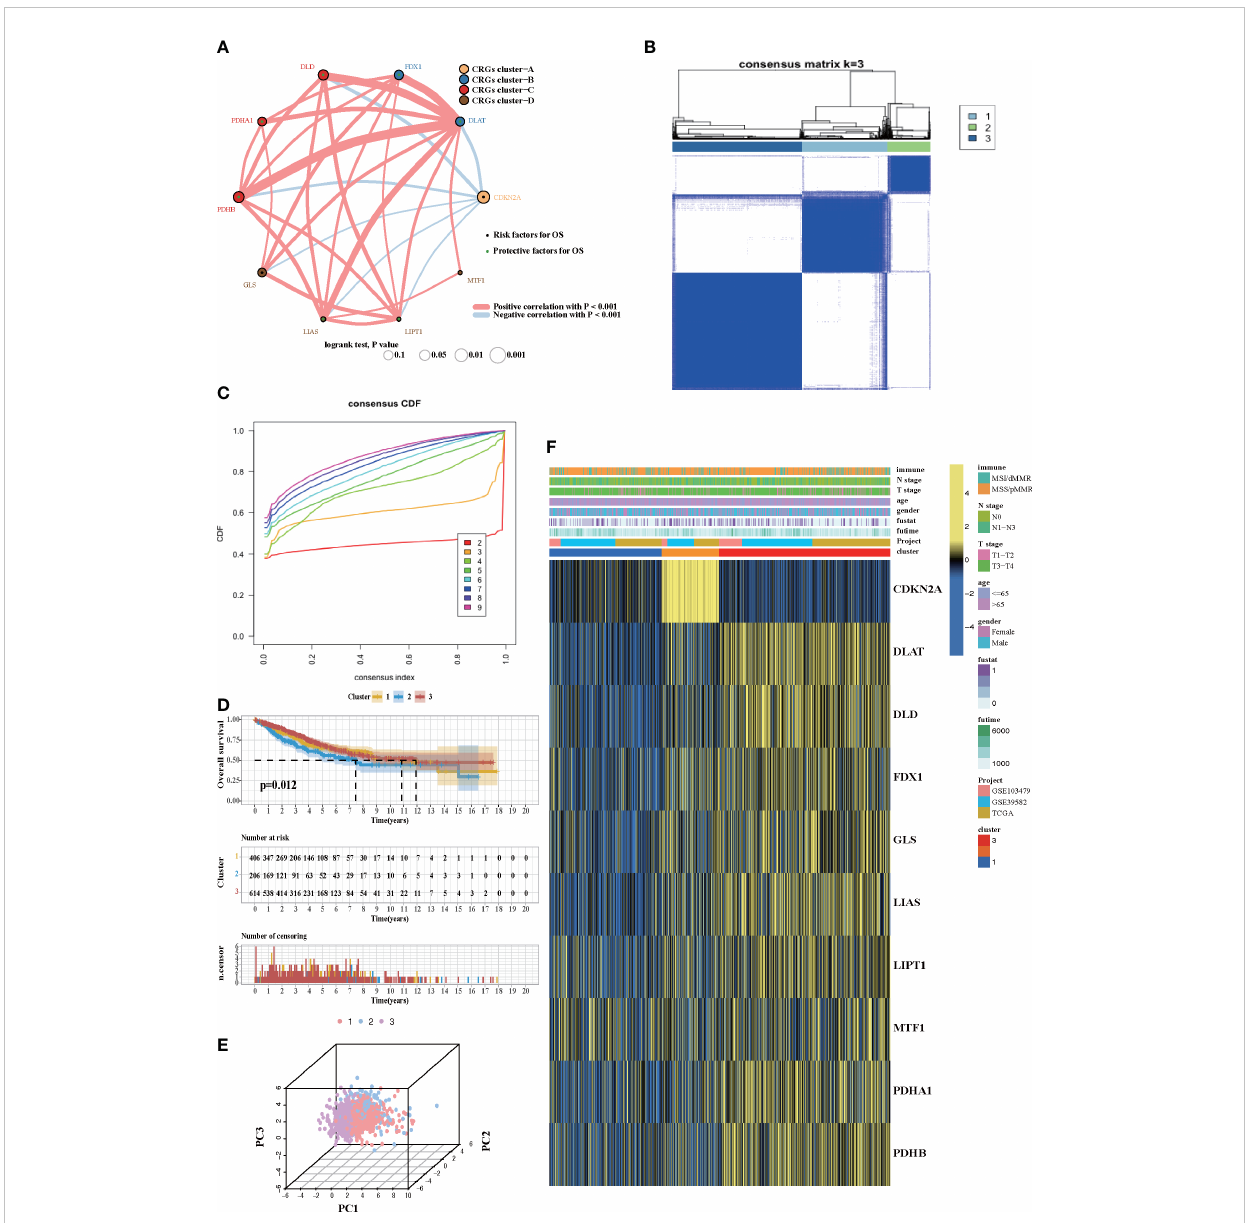
FIGURE 2 Cuprotosis patterns in CRC patients. (A) The network between 10 CRGs in CRC patients. The size of the circle corresponded to the effect of each gene on the patients ’ prognosis, and the range of values was scaled by log-rank test. Protective factor for patients ’ OS was illustrated by a green dot, and risk factors was illustrated by a black dot. The lines showed the interaction of each gene, and the thickness represented the correlation strength. Blue lines indicated negative correlation, and red lines indicated positive correlation. The CRG cluster A – D was marked with yellow, blue, red, and brown, respectively. (B) Unsupervised consensus clustering for 10 CRGs in the meta-cohort and the consensus matrices for k = 3. (C) Consensus values range from 0 to 1. (D) Kaplan – Meier curves for the three cuprotosis patterns based on 1,226 CRC patients from the meta-cohort, including 406 samples in COPcluster C1, 206 samples in COPcluster C2, and 614 samples in COPcluster C3 (log-rank test). The COPcluster C3 showed a signi fi cantly better prognosis than the other two COPclusters. (E) The transcriptome pro fi les of three cuprotosis patterns were analyzed by principal component analysis, revealing a striking difference in transcriptome pro fi les between different patterns. (F) Expression heatmap of three COPclusters of 10 CRGs in the meta-cohort. Immune subtype, age, gender, N stage, T stage, and prognosis were annotated. Yellow represents a high expression of CRGs, and blue represents a low